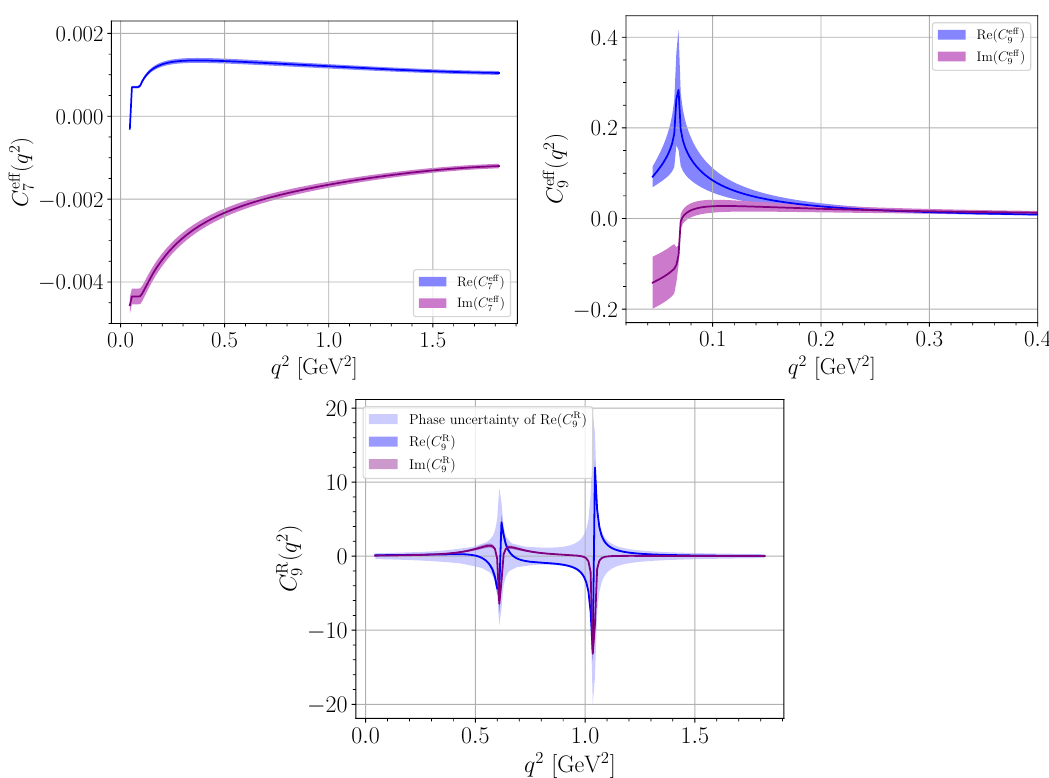
(upper left), Figure 9 . Real (blue) and imaginary (lilac) parts of perturbative contributions to C eff 7 (upper right) and the resonant C R (bottom) in the SM as functions of q 2 . C eff ( q 2 ) remains C eff 9 9 9 essentially constant for q 2 & 0 . 4 GeV 2 and is therefore not shown. The main source of uncertainty in the perturbative contributions is due to the scale uncertainty µ and indicated as bands. In the c resonant case the solid lines show C R for fixed phases δ = δ = 0 , whereas the shaded (blue) area φ ω 9 corresponds to Re C R including uncertainties from varying phases. The corresponding uncertainty 9 band for Im C R is not shown because it is very 9